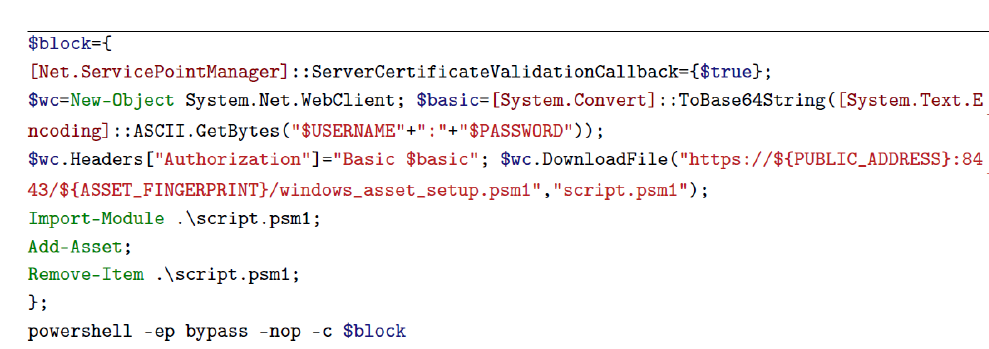
Figure 2. Asset joining one-liner for Linux.